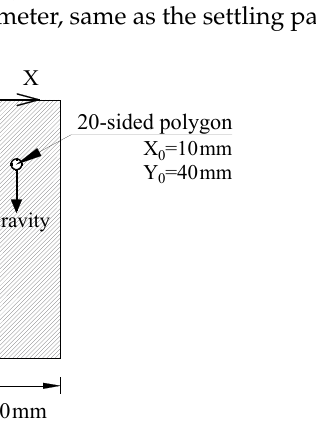
Figure 5. Sedimentation model diagram and the initial location of the settling particle in the fluid container.